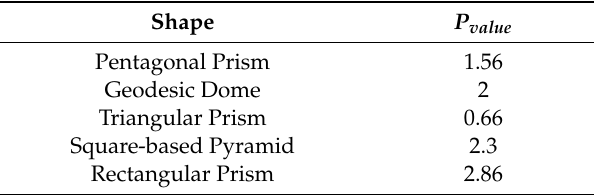
Table 1. P value of several simple greenhouse